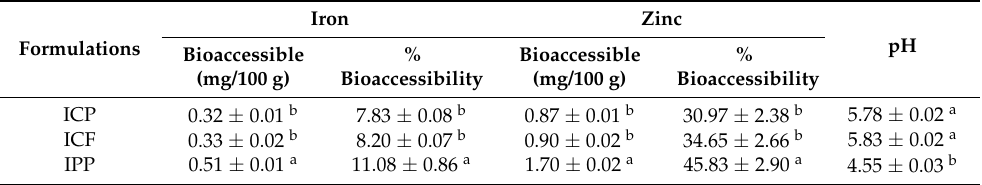
Table 6. In vitro iron and zinc bioaccessibility and pH of instant porridge powders.